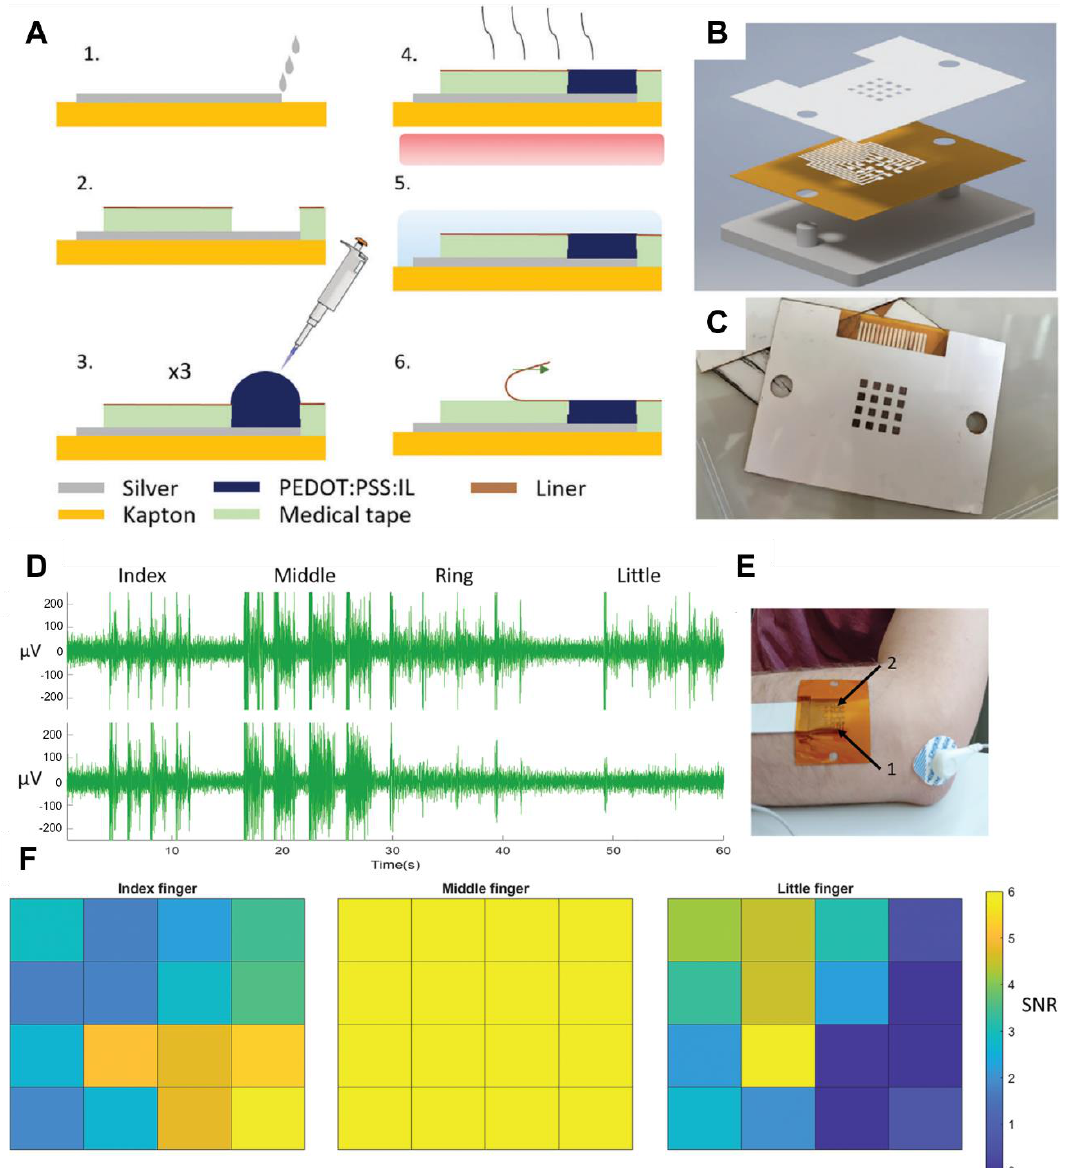
Figure 15. Scheme of the fabrication process of the electrode arrays ( A ). Schematic view of the assembly process of the device showing the aligning holder ( B ). Photo of a device before measuring ( C ). Typical EMG recordings from two electrodes during the motion of different fingers ( D ). Photo showing the location of the electrode array and the reference electrode. The arrows indicate the location of the two electrodes, over the extensor carpi ulnaris (1) and the extensor digitorum communis (2) muscles ( E ). Heat maps showing the normalized signals recorded by the array during the motion of different fingers ( F ). Adapted under the terms of the CC-BY-4.0 license [145]. Copyright 2021, The author(s).